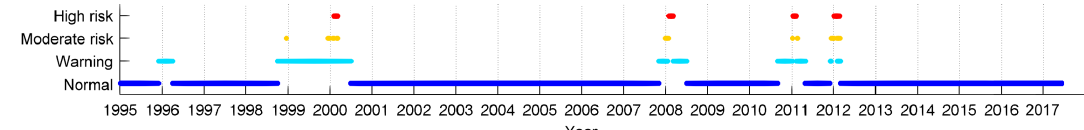
Figure 9. Warning lights on cold water days for the Penghu Islands.